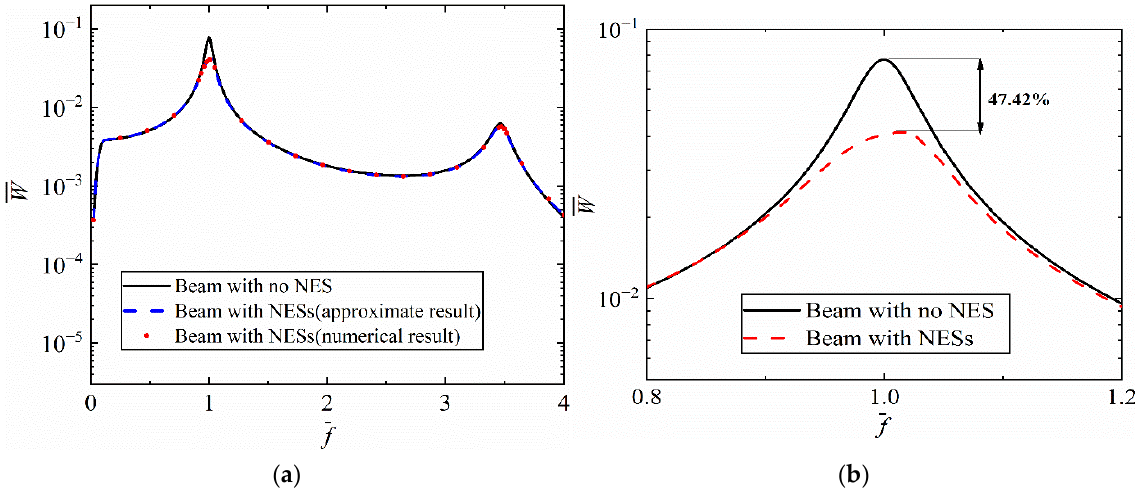
Figure 4. ( a ) Numerical verification; ( b ) local magnified view.